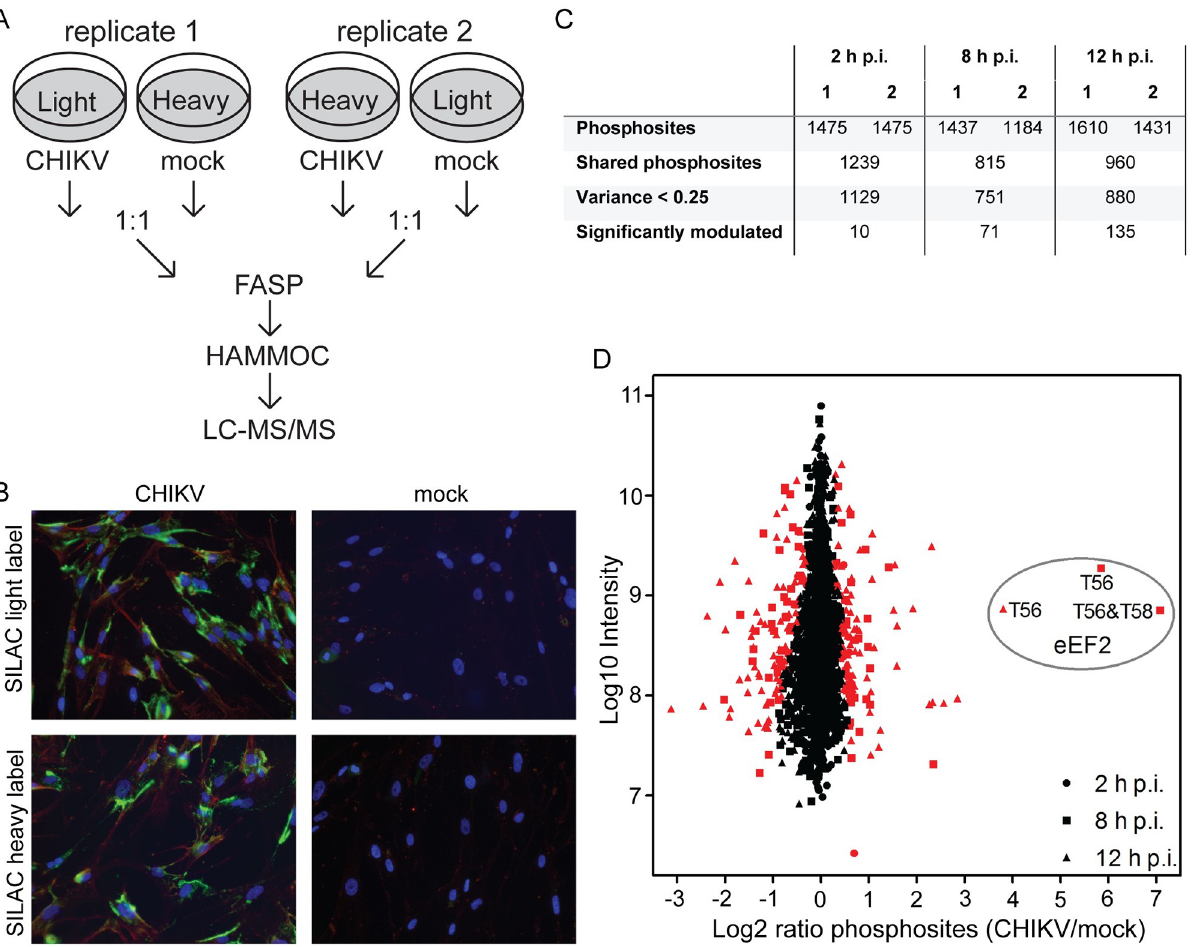
Fig 1. Phosphoproteomics analysis of CHIKV infection. ( A ) Experimental set-up of the SILAC-based phosphoproteomics study of virus-induced changes in the host proteome during the course of CHIKV infection. At each time point two biological replicates were used, in which a SILAC label- swap was performed between infected and mock-infected samples. Infected and mock-infected cells were lysed at 2, 8, and 12 h p.i. and equal amounts of protein were mixed and subsequently digested into peptides using the filter-aided sample preparation procedure. The samples were enriched for phosphopeptides using the HAMMOC procedure and analyzed by LC-MS/MS. ( B) Immunofluorescence microscopy analysis of SILAC-labeled CHIKV-infected cells fixed at 12 h p.i. Cells were immunolabeled for dsRNA (green) and the CHIKV E2 protein (red), and nuclear DNA (blue) was stained with Hoechst-33342. (C) Number of identified phosphorylation sites at each time point p.i. The number of identified phosphorylation sites for each biological replicate and the total number of phosphorylation sites that were identified in both replicates at each time point p.i. are shown. For follow-up analysis only phosphorylation sites with a variance < 0.25 were selected. ( D ) Proteome-wide quantification of phosphorylation sites at 2 (dots), 8 (squares), and 12 (triangles) h post-CHIKV infection. Average normalized log 2 ratios (Infected/mock) are plotted against the log 10 of peptide intensities measured in the mass spectrometer. Each mark represents a protein group (proteins (often isoforms) that are grouped together due to shared peptide identifications). Red marks indicate phosphorylation sites that were significantly modulated (Benjamini-Hochberg FDR of 0.05). The phosphorylation sites identified for eEF2 at 8 and 12 h p.i. are